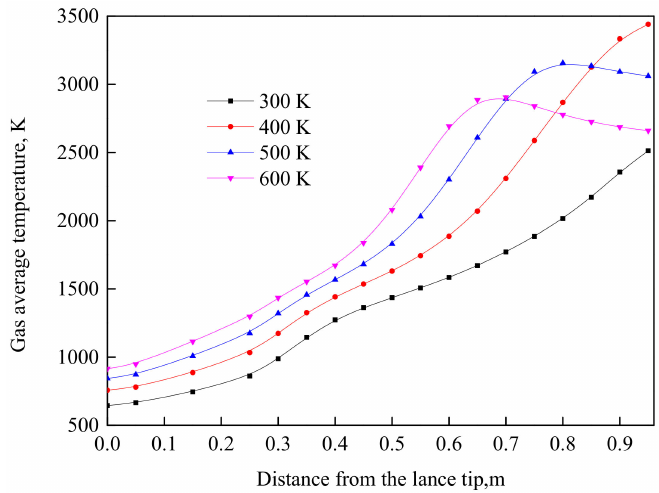
Figure 8. E ff ect of oxygen temperature on average gas temperature along the centerline.